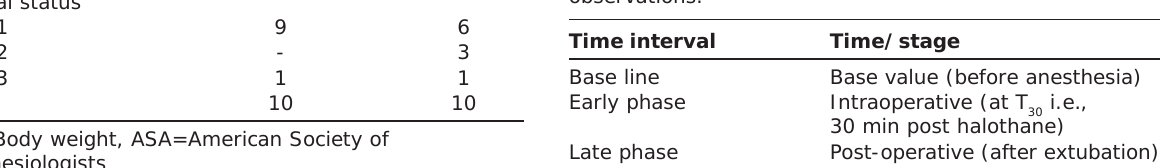
Table-3: Time interval for hemato-biochemical